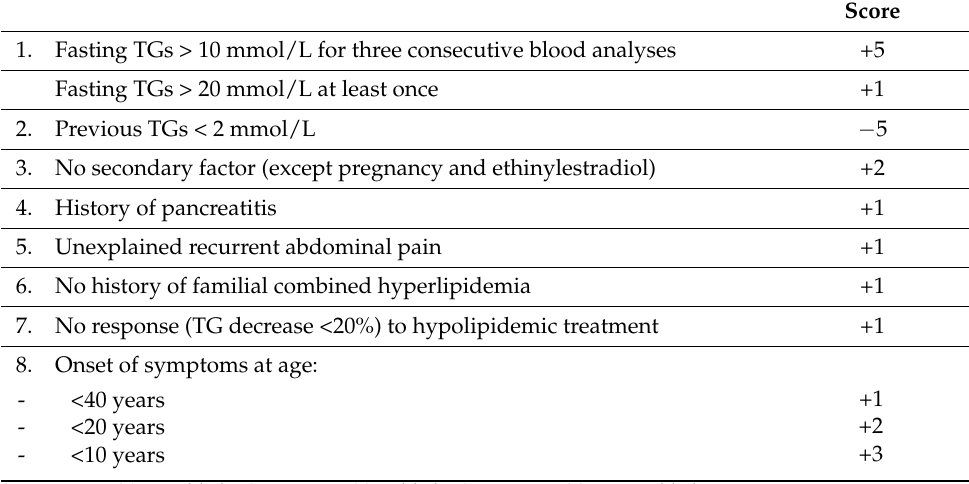
Table 1. Familial chylomicronemia syndrome scoring, according to Moulin et al.